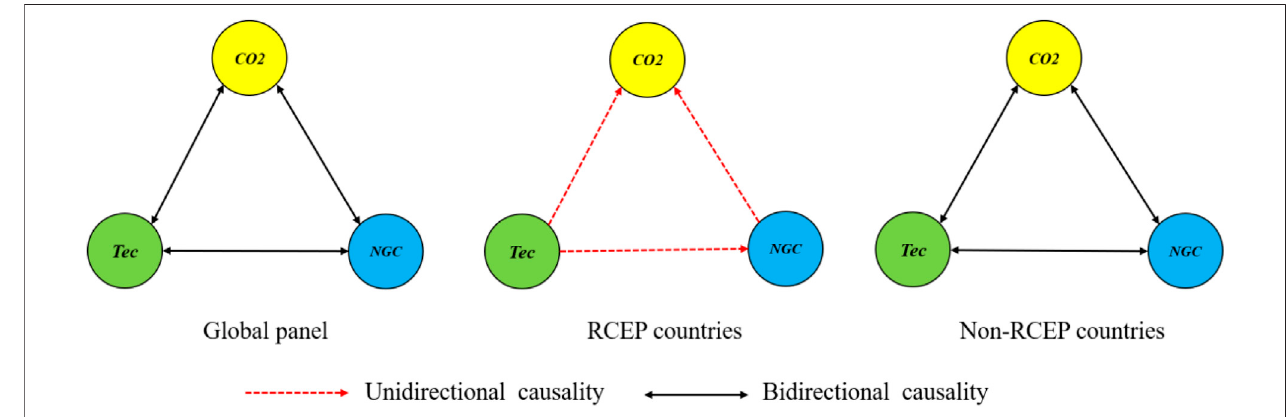
FIGURE 1 | Results of causality movements for the full panel and two